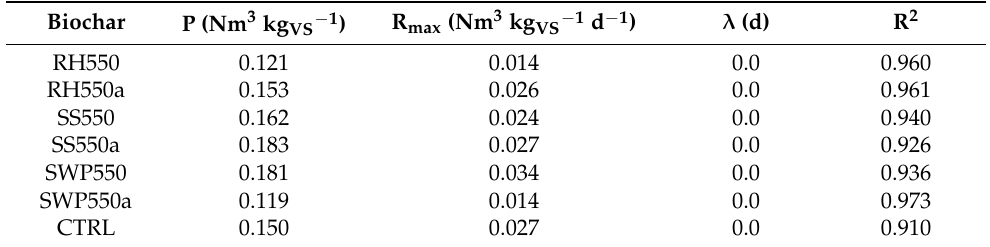
Table 3. Kinetic parameters of methane production based on the modified Gompertz model.